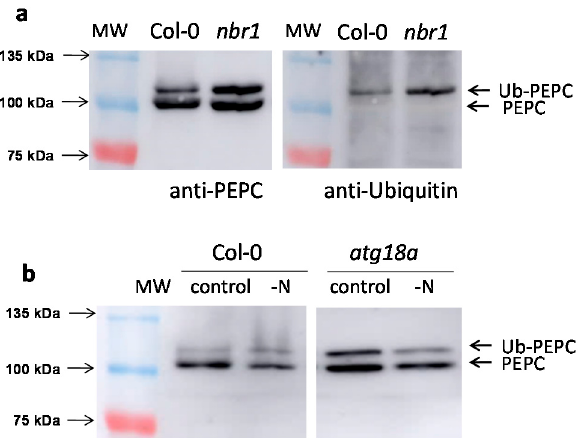
Figure 3. The amount of monoubiquitinated PEPC increases in the nbr1 and atg18a SALK lines. Arabidopsis Col-0, nbr1 , and atg18a SALK lines were hydroponically grown for six weeks. Leaves from 30 plants were pooled and protein aliquots corresponding to 10 mU of PEPC were analyzed by SDS-PAGE. ( a ) Leaf extracts from Col-0 and nbr1 . Immunoblots with anti-PEPC and anti-ubiquitin antibodies of the same membrane. ( b ) Leaf extracts from Col-0 and atg18a . When indicated, N was suppressed from the culture medium for 1 week. Several lanes are omitted for clarity. Table 1. The amounts of monoubiquitinated PEPC increased in autophagy-defective Arabidopsis lines.